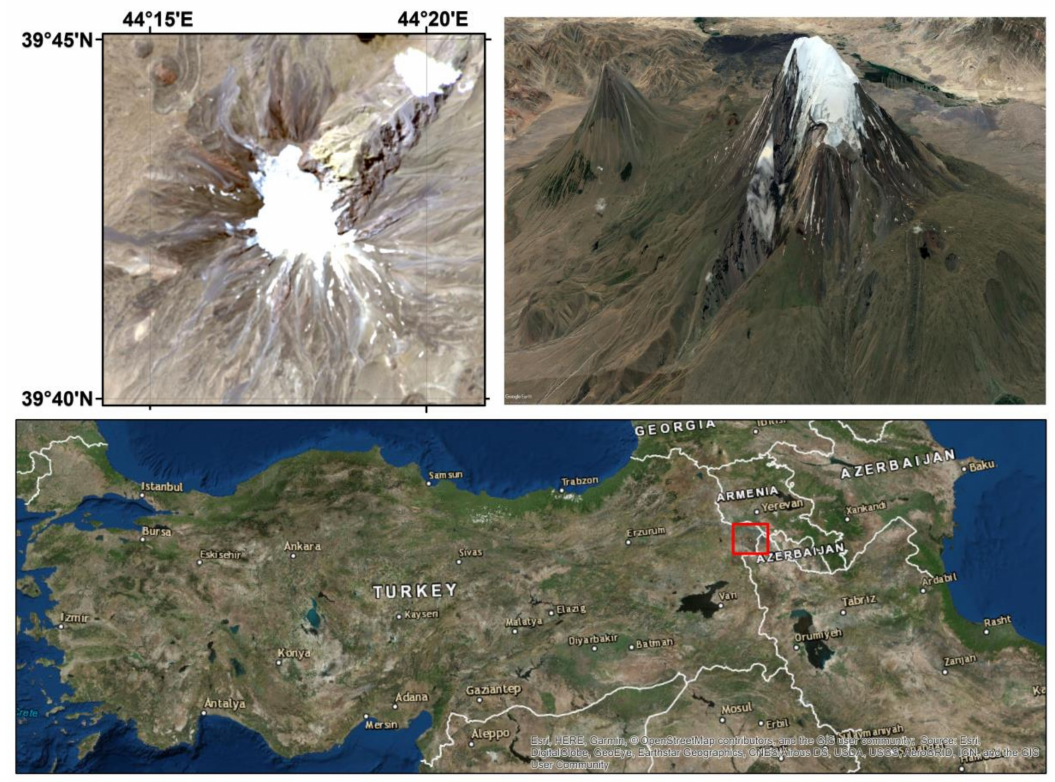
Figure 1. Study Area (A˘grı